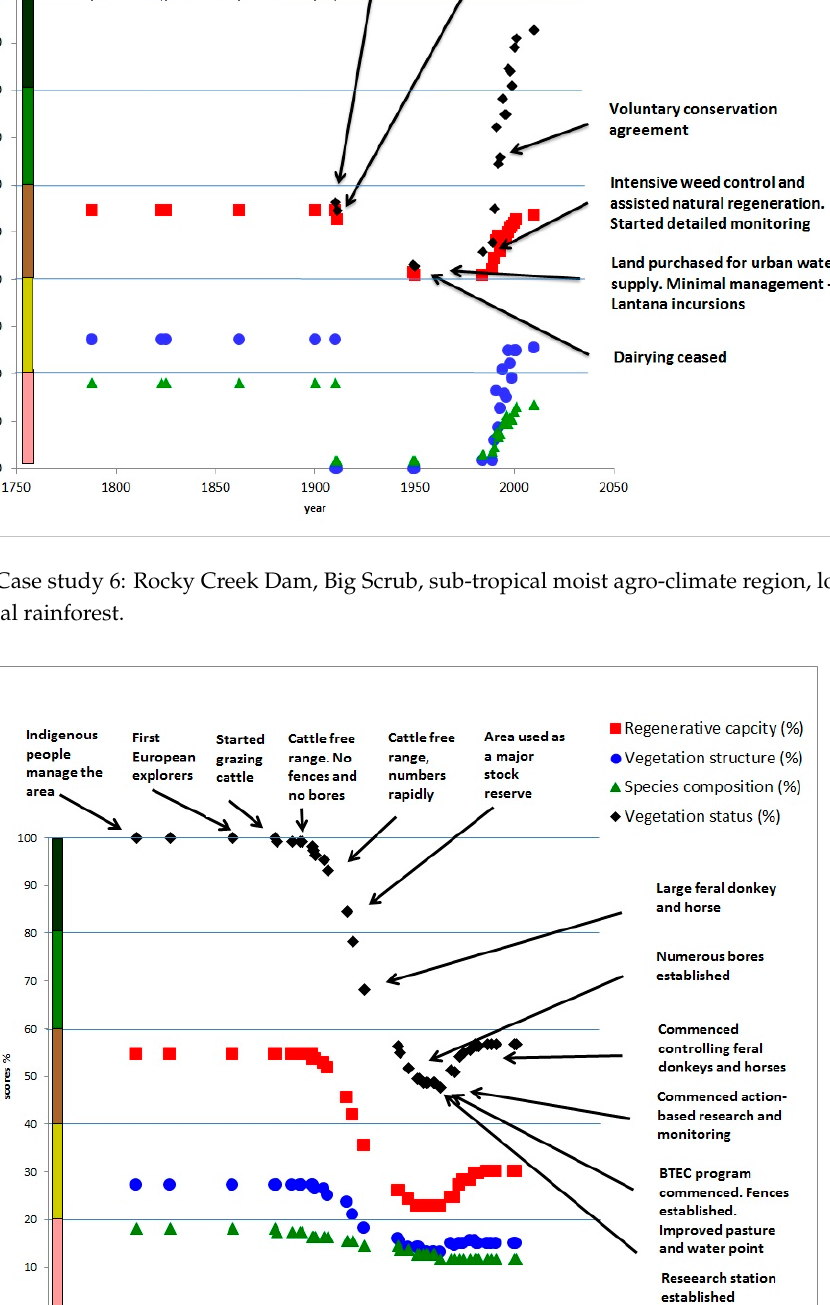
Figure 8. Case study 7: Conkerberry Paddock, Victoria River Research Station, tropical warm season wet agro-climate region, eucalypt open woodland.